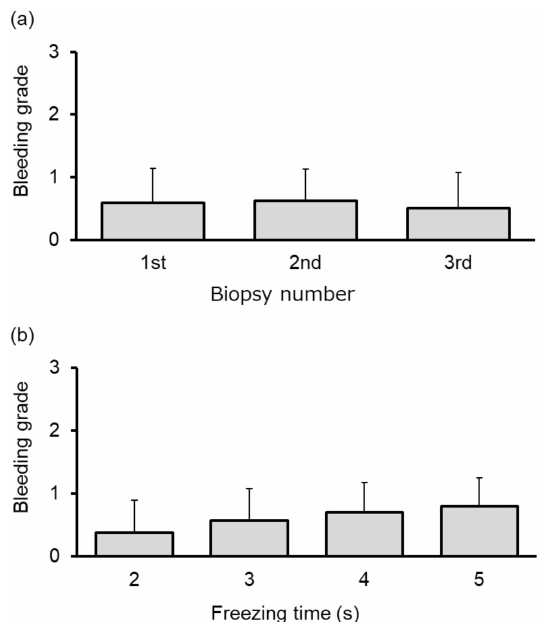
Figure 4. Severity (grade) of bleeding according to ( a ) the cryobiopsy number (first, second, third) and ( b ) the freezing time during cryobiopsy (2-, 3-, 4- and 5-s) in patients with peripheral pulmonary lesions. The severity of bleeding did not differ according to the number of biopsies ( p = 0.913; Figure 4a) or the freezing time ( p = 0.451; Figure